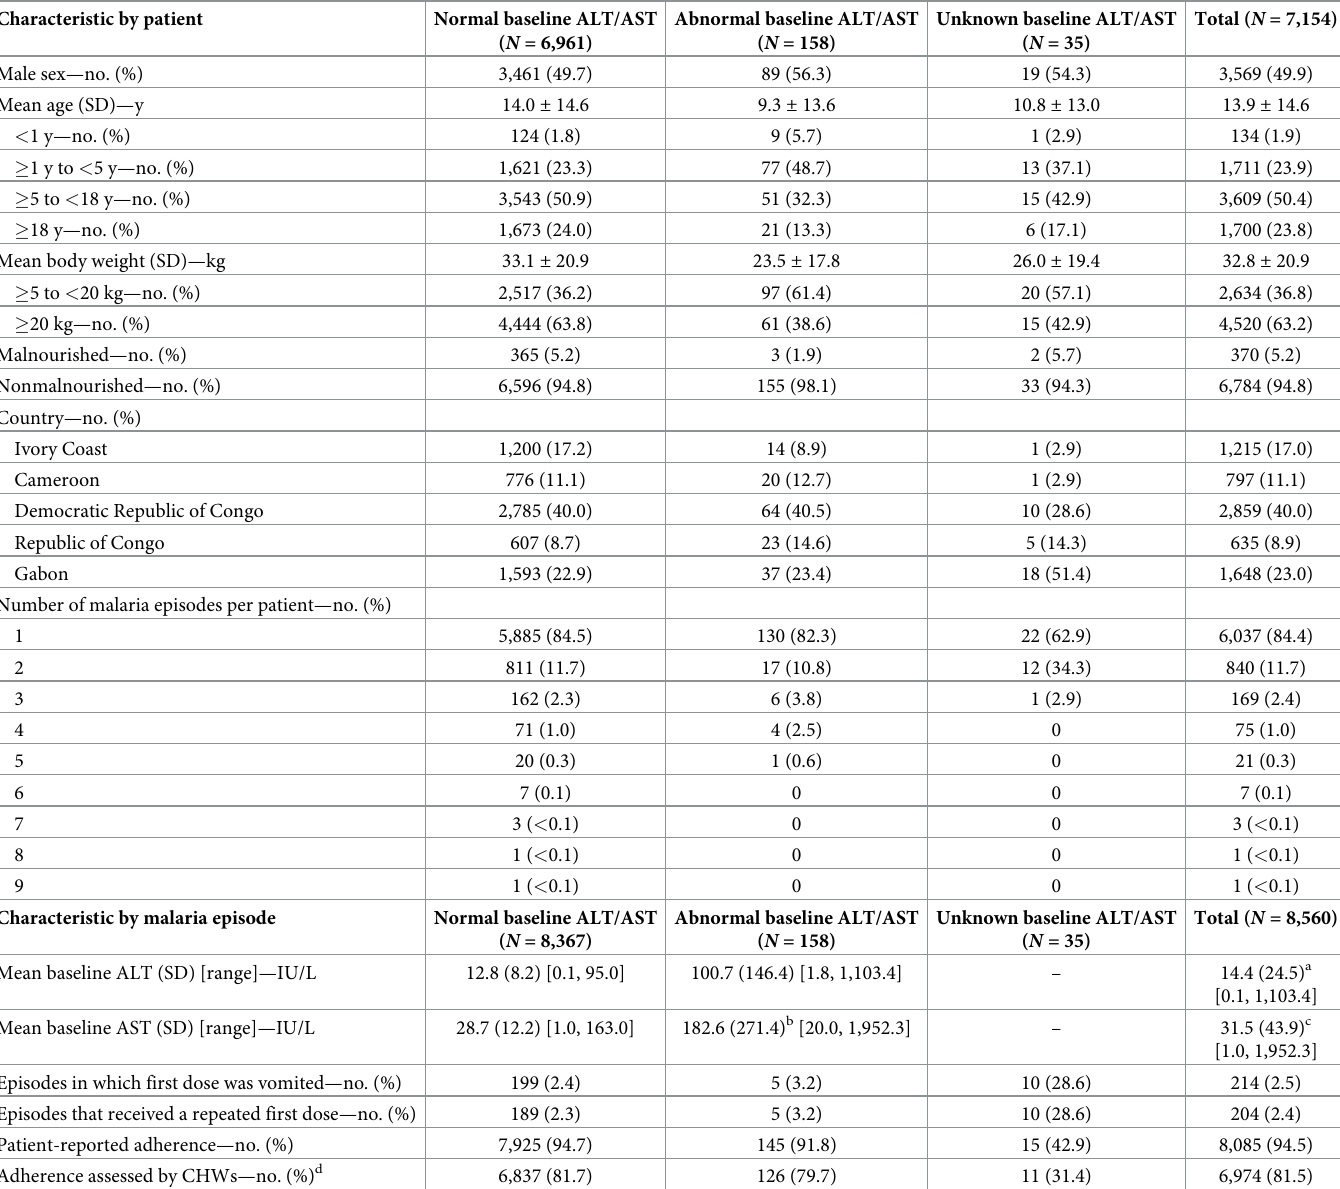
Table 1. Baseline demographic and clinical characteristics in the safety population. Characteristic by